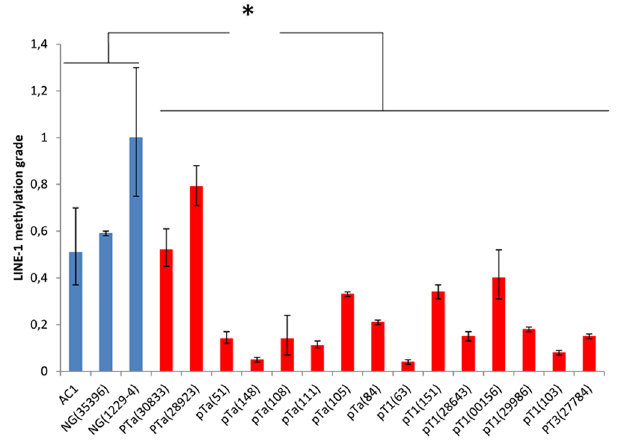
Figure 6. Relative quantification of LINE-1 methylation in UC. LINE-1 methylation was measured by real time IDLN-MSPCR in three healthy- and in eight pTa-, six pT1- and one pT3 UC samples, each with the corresponding sample ID (Table 1). Significant differences between the two groups (p < 0.05) were verified by the Student’s t-test *